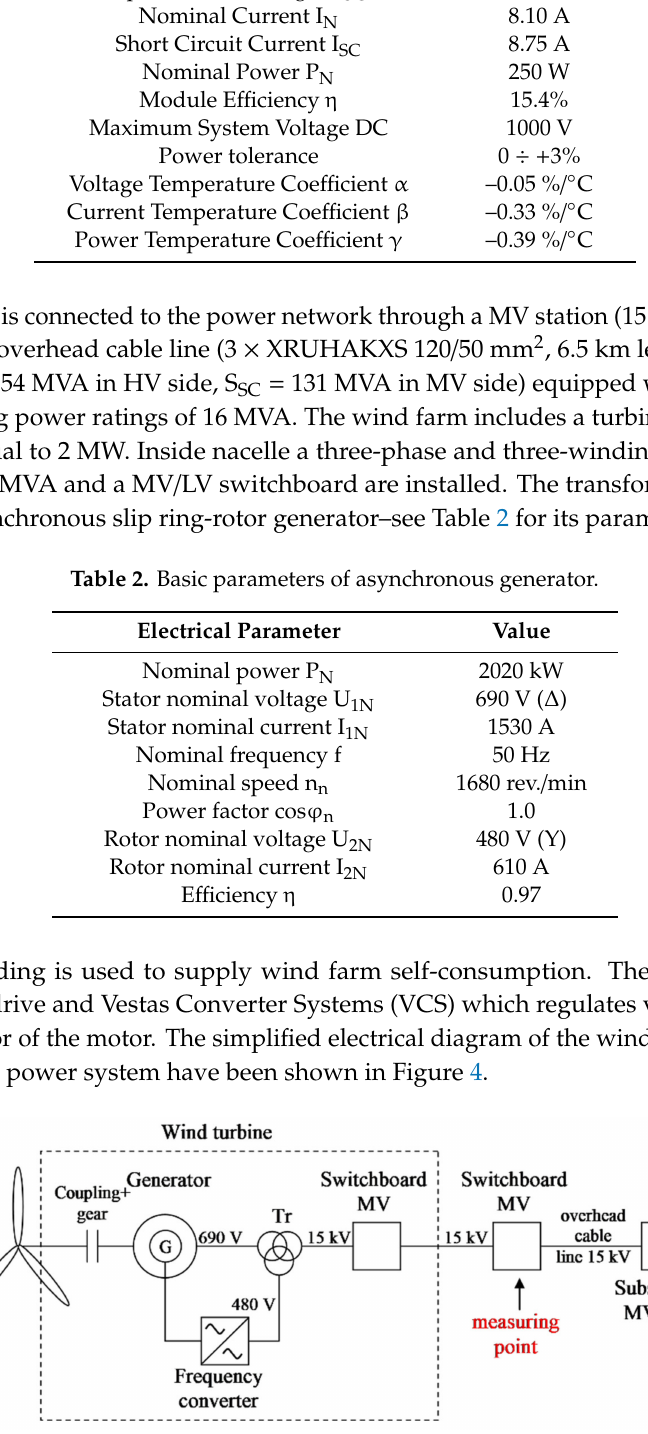
Figure 4. Simplified diagram of the wind power